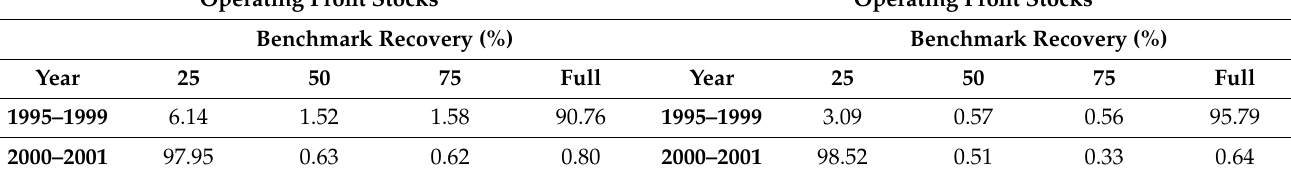
Table 2. Cont. Panel E: Recovery Probabilities for LPM Ratio of Big–High